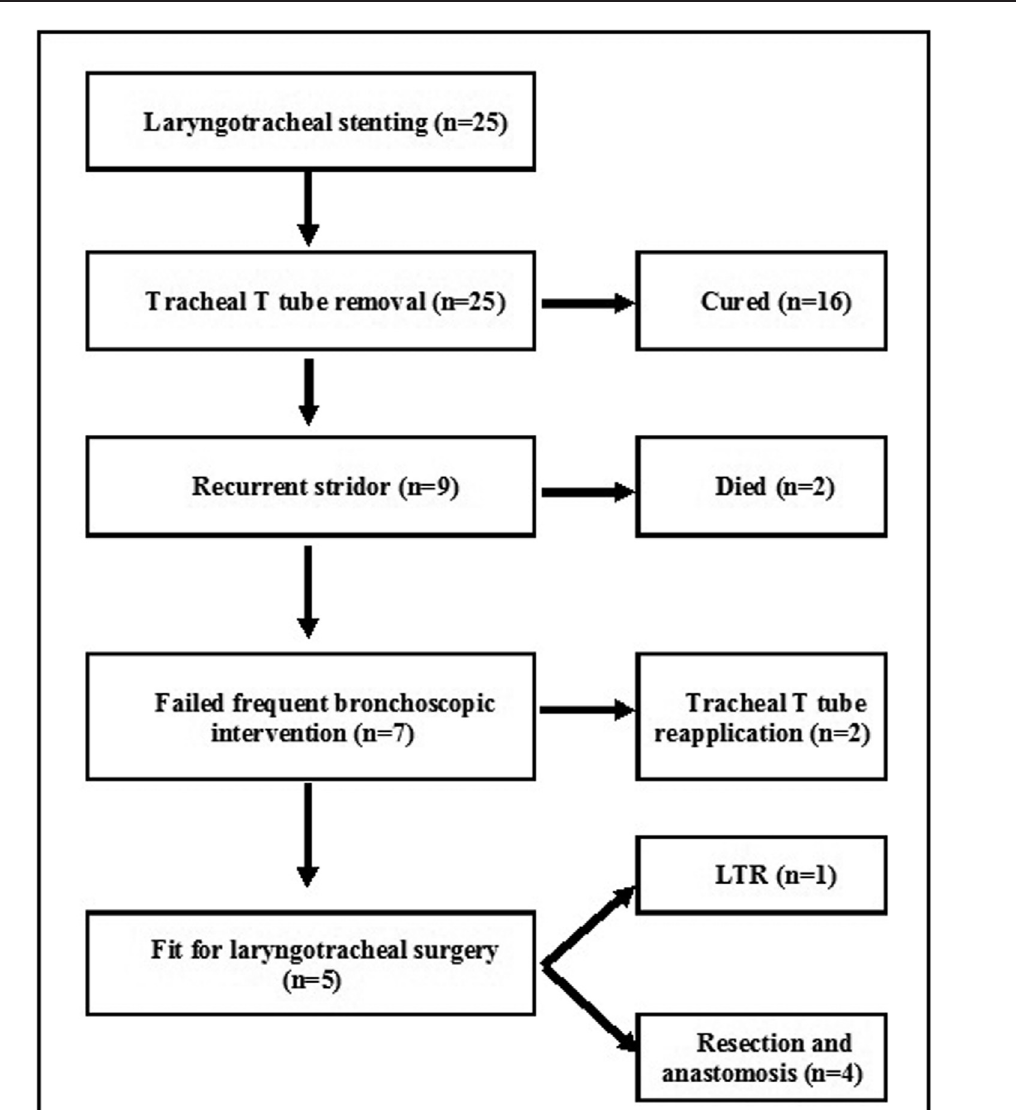
Flowchart of management and